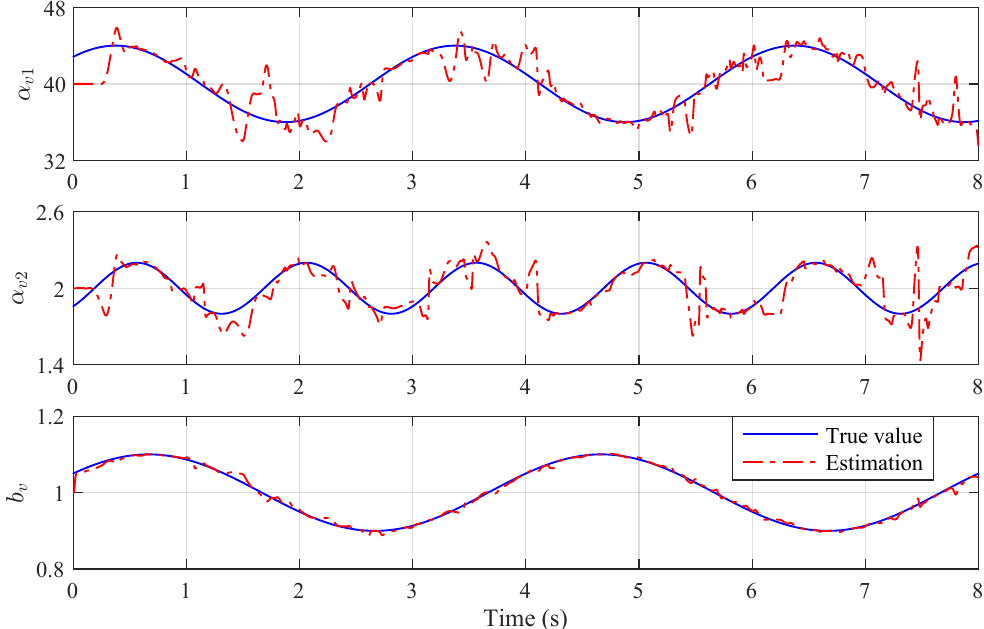
Figure 2. True values and estimations of the original plant’s parameters.